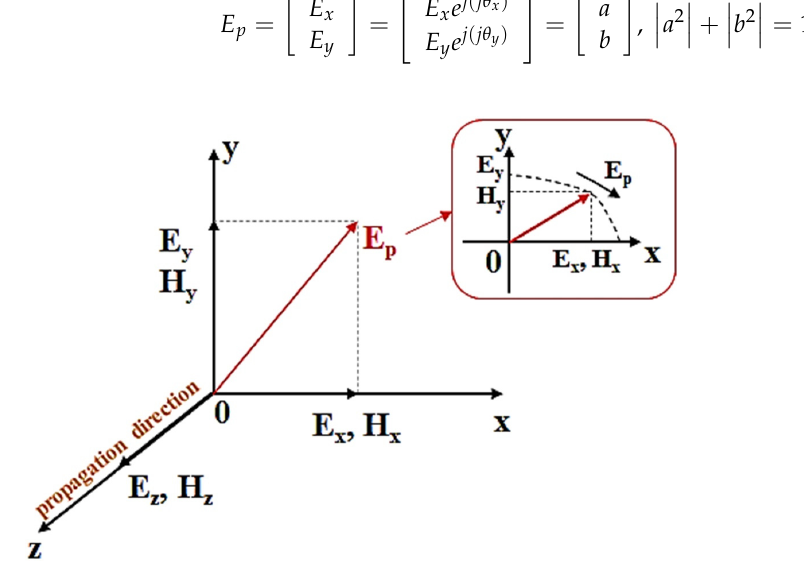
Figure 4. Direction of filter rotation angle ( E 2 ). Diagnostics 2022 , 12 , x FOR PEER REVIEW